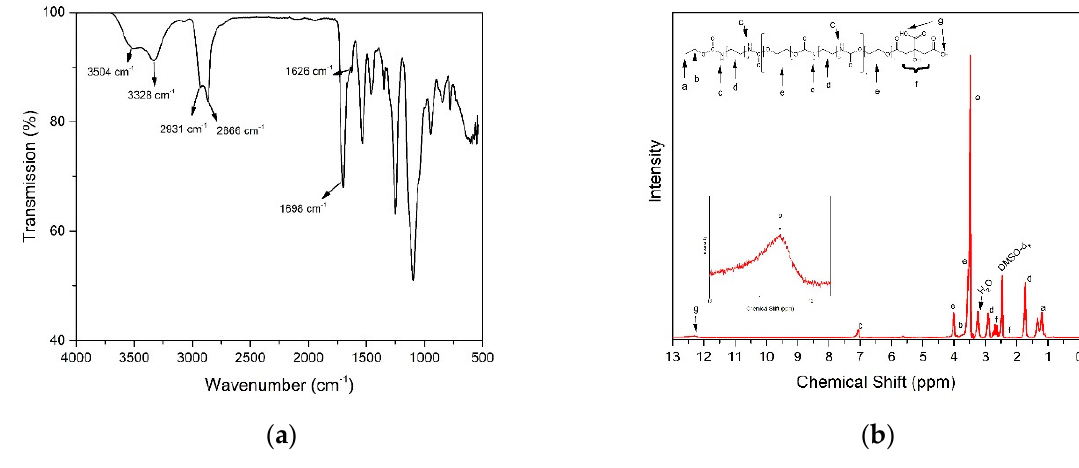
Figure 4. FTIR ( a ) and 1 H NMR ( b ) spectra of PUR-COOH.